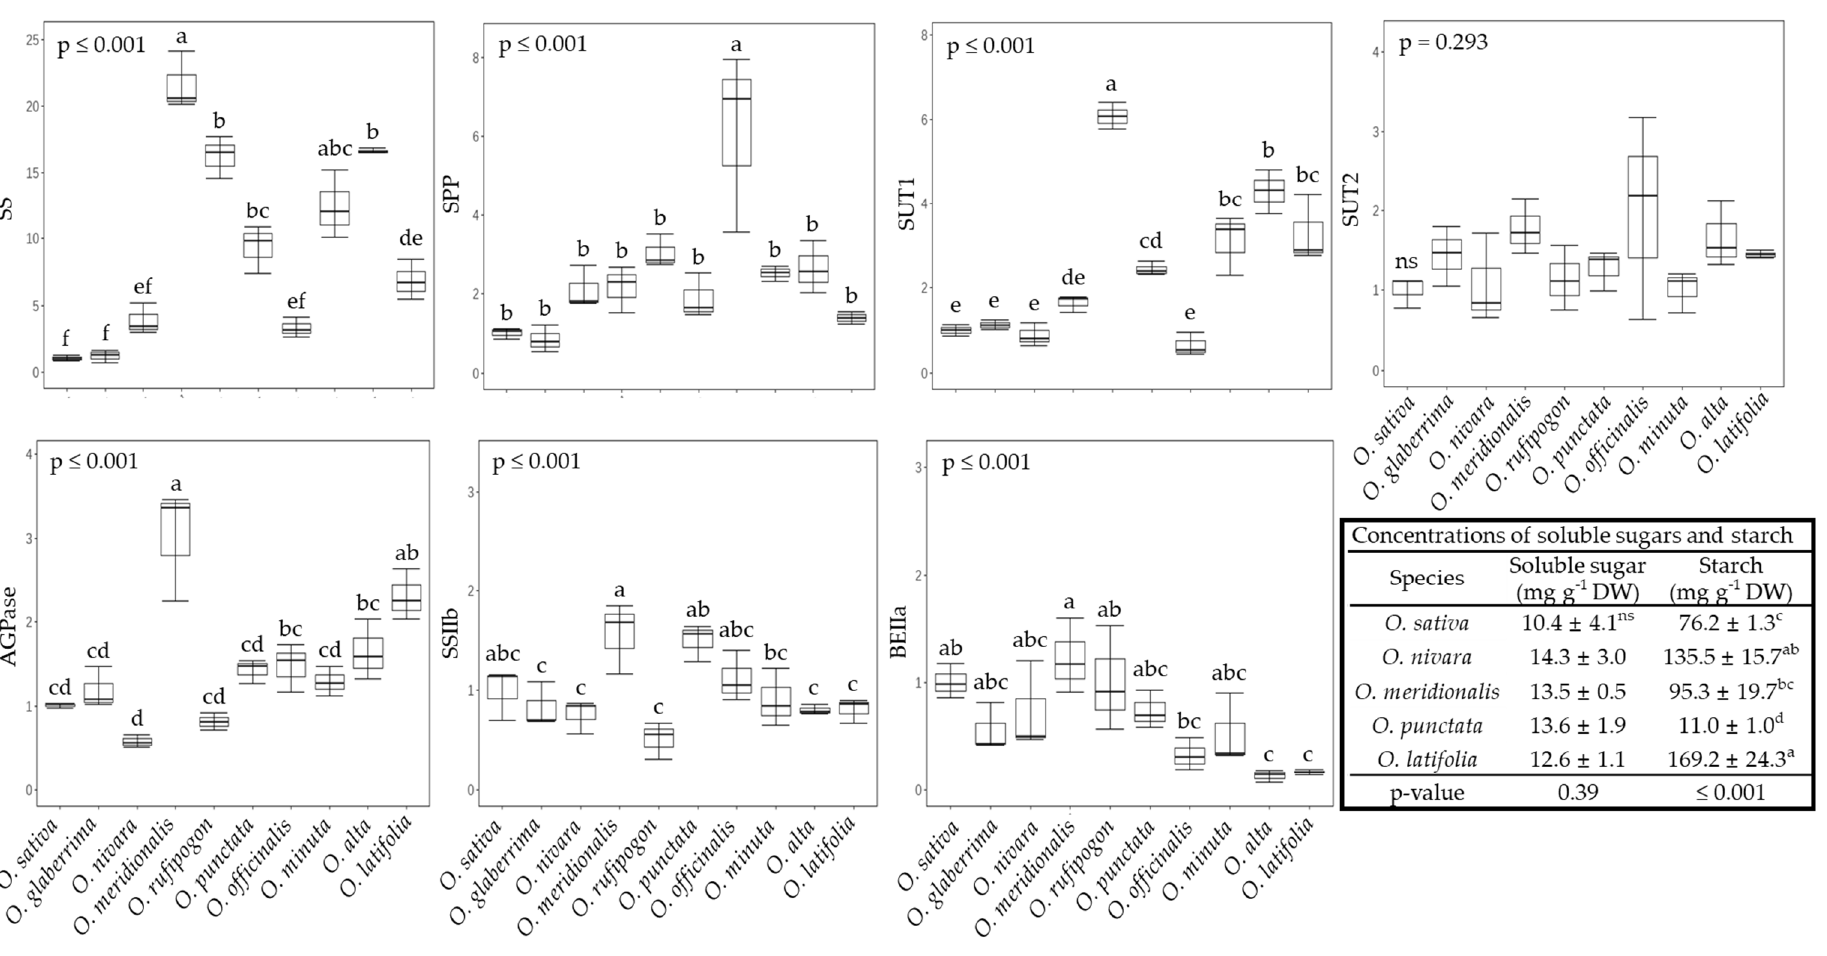
Figure 5. Comparison of relative gene expression encoding several major enzymes associated with sucrose and starch biosynthesis and sucrose transport and the concentrations of total soluble sugars and starch between wild rice species at 60 DAT (mean of three replications ± S.D.). Means followed by different letters in the same raw are significantly different at p < 0.05 according to Tukey’s HSD test. SS, sucrose synthase; SPP, sucrose phosphatase; SUT1 and 2, sucrose transporter 1 and 2; AGPase, ADP-glucose pyrophophorylase; SSIIb, soluble starch synthase; BEIIa, starch branching enzyme.